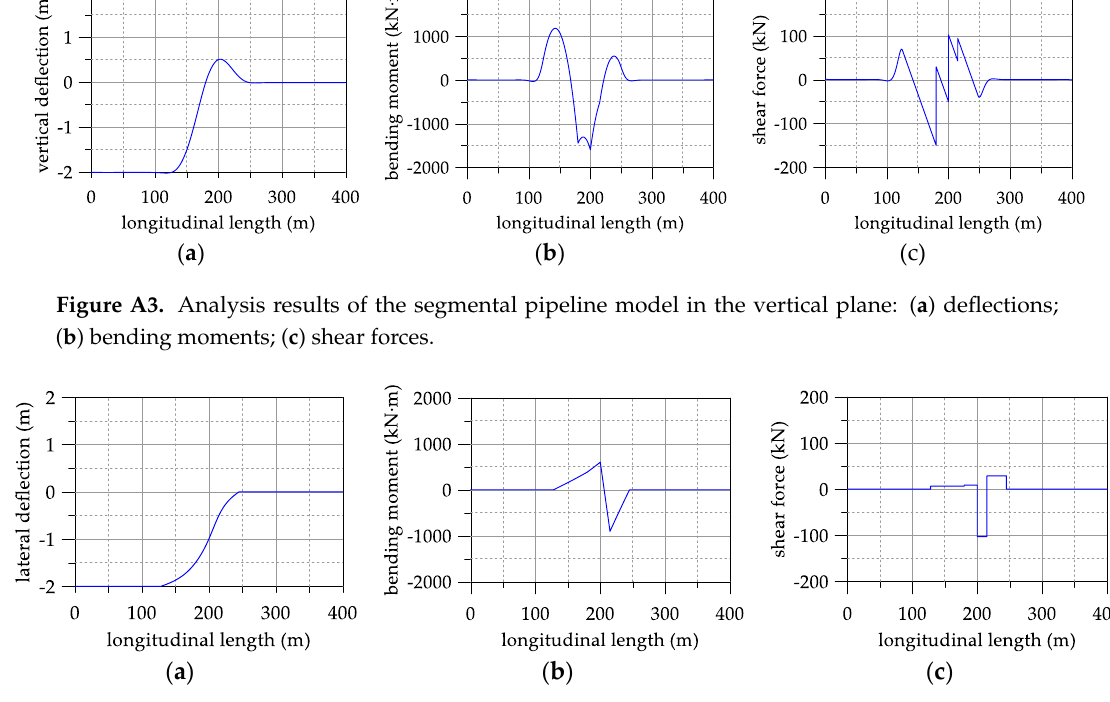
Figure A4. Analysis results of the segmental pipeline model in the lateral plane: ( a ) deflections; ( b )